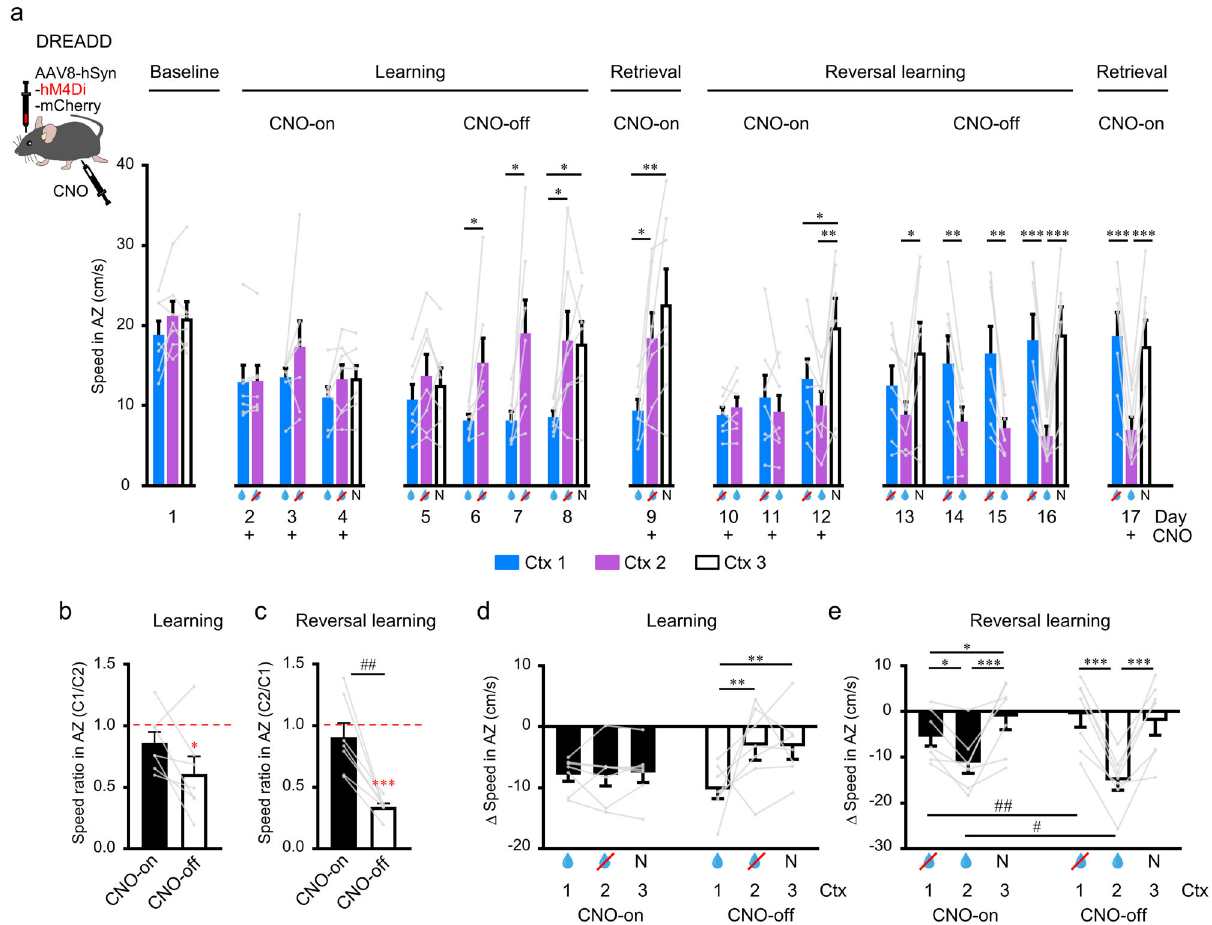
Fig. 6 Behavioral context discrimination is impaired by chemogenetic inactivation of the RSC. a Mean running speed in the anticipation zone for mice injected with AAV8-hSyn-hM4Di-mCherry to express inhibitory DREADD. CNO was applied either during the memory formation process (days 2 – 4